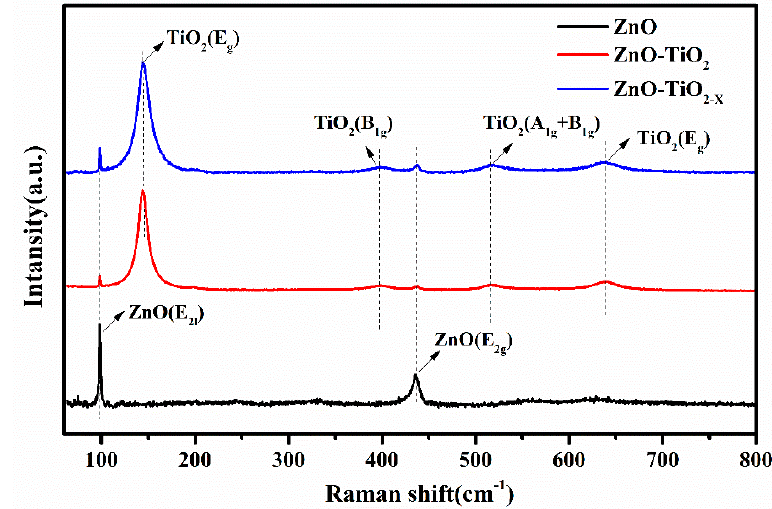
Figure 4. Raman spectra of TiO 2 NRs, ZnO/TiO 2 , ZnO/TiO 2-X .